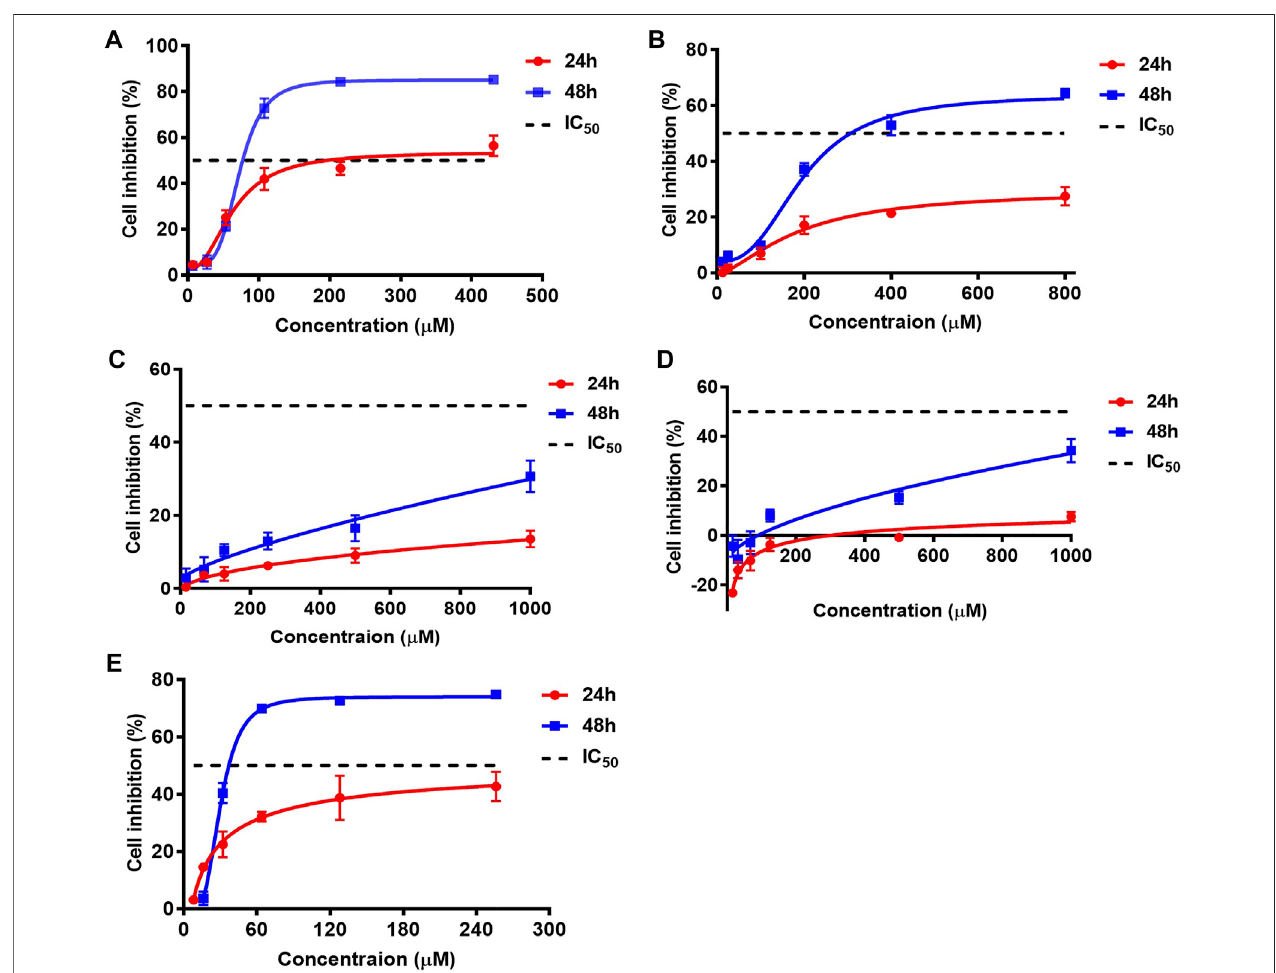
FIGURE 2 | Cell inhibitions of HK-2 after treating with AA I (A) , AA II (B) , AA IIIa (C) , AA IVa (D) , and AL I (E) for 24 or 48 h. IC 50 values of AAAs were obtained by nonlinear regressionand least square fi tting ofthedata to[inhibitor] vs. response-variable slope(four parameters) model using GraphPadPrism 7.0. Inhibition data were calculated from fi ve parallels at each concentration and repeated for three